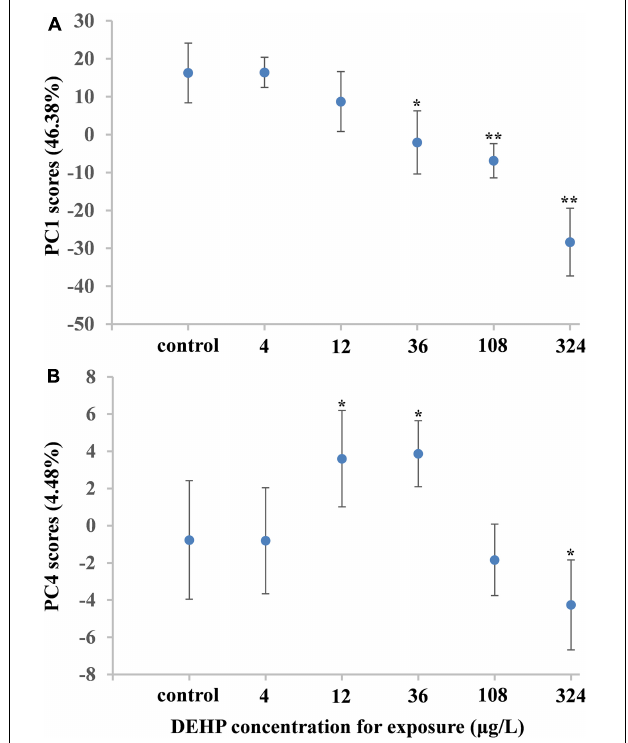
FIGURE 4 | Characteristics of DEHP-treated groups and control using principal component analysis. Graphs show mean scores (with standard error bars). The average scores along PC1 (46.38% variation) decreased linearly, presenting a monophasic dose-response relationship along the PC1 axis (A) . The average scores along the PC4 (4.48% variation) axis had an inverted U-shaped curve with two moderate concentrations (12 and 36 µ g/L) of DEHP treatments located at the top (B) . The one-way ANOVA indicated a significant difference ( ∗ P < 0.05, or ∗∗ P < 0.01) between DEHP-exposed groups and control